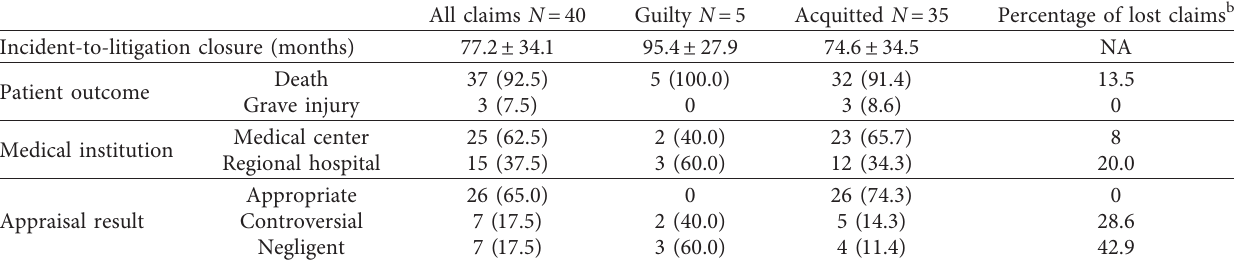
Table 2: Characteristics of medical malpractice claims according to guilty or acquitted verdicts a .